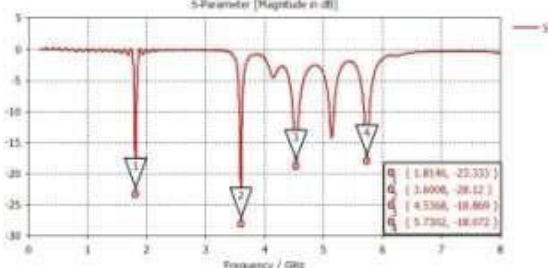
parameter of the designed antenna. Figure 2: S 11